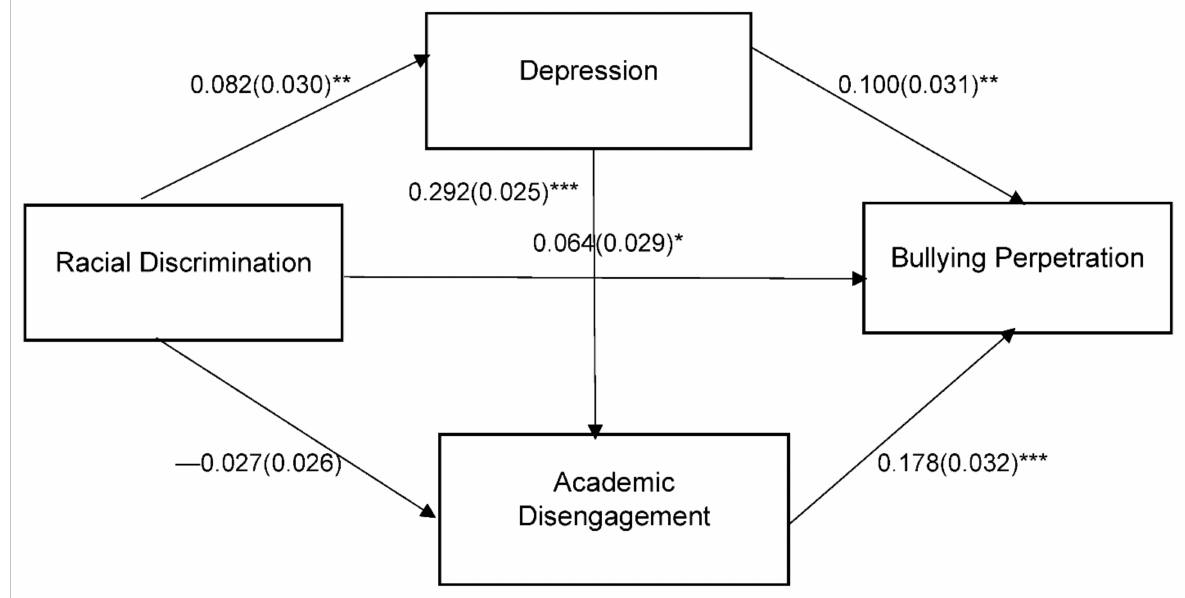
Figure 2. Pathways from Racial Discrimination to Bullying Perpetration for Black Adolescents. Note: Controlled for child sex, child age, caregiver’s sex, and caregiver’s age; standardized coefficients are presented, and standard error is in the parentheses. * p < 0.05; ** p < 0.01; *** p <